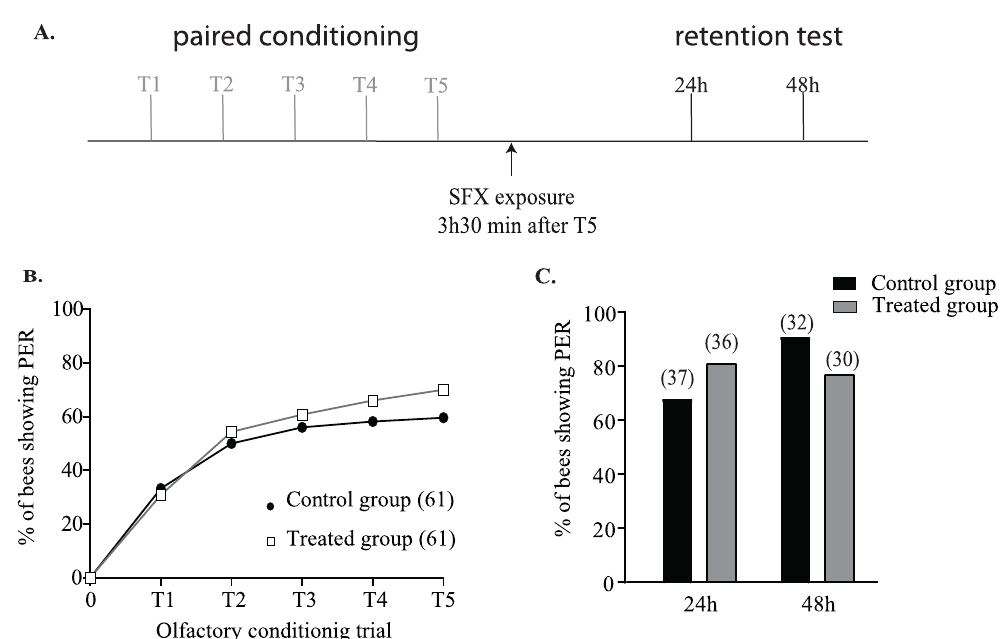
Fig 5. Effect of sulfoxaflor sublethal dose on memory processes after exposure 3h30 after conditioning. A . Experimental procedure used in protocol 3: 3 h 30 after the last olfactory conditioning trial (T5), treated and control bees received 2 μ L of SFX solution (15 ng/bee) or 50% (w/v) sucrose solution respectively. B . The response (PER or no PER) of each bee was registered during each conditioning trial. Only survival bees showing a proboscis extension response at the end of the olfactory conditioning were considered for the restitution test. C . The restitution tests were performed 24 h and 48 h after the last olfactory conditioning trial. Asterisks indicate statistically significant differences in the treated group response compared to the control group (P < 0.05). The number of individuals in each group is given in the